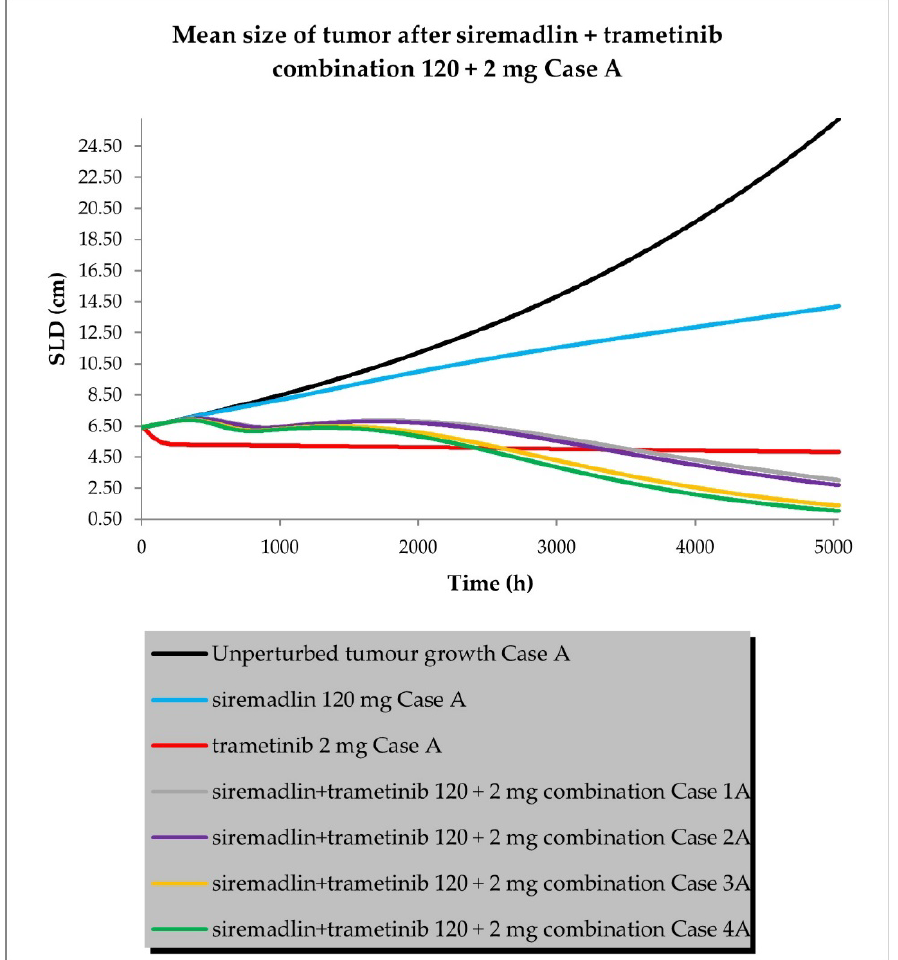
Figure 10. Siremadlin and trametinib combination’s 120 + 2 mg efficacy in population representative of melanoma cancer (Case A—high tumour growth, high initial tumour size, and high fraction of sensitive cells).